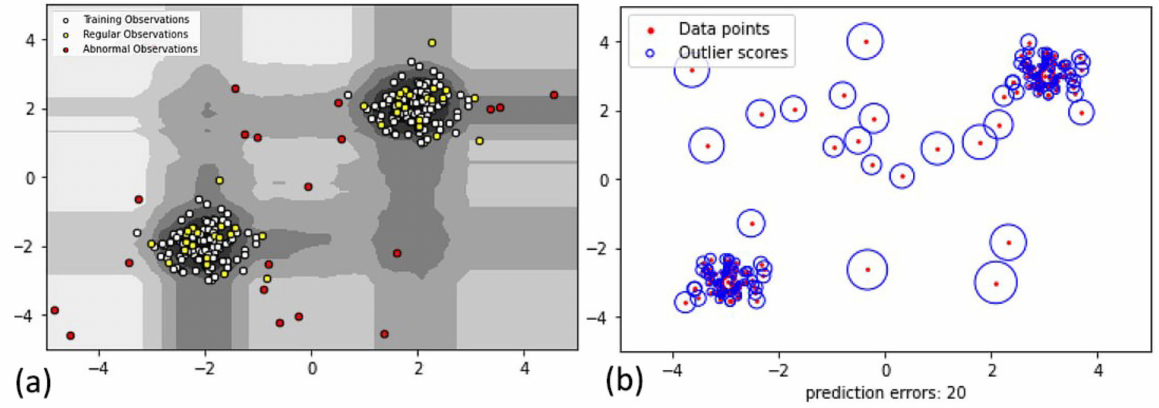
Figure 18. Unsupervised outlier detection with the ( a ) isolation forest algorithm, ( b ) LOF